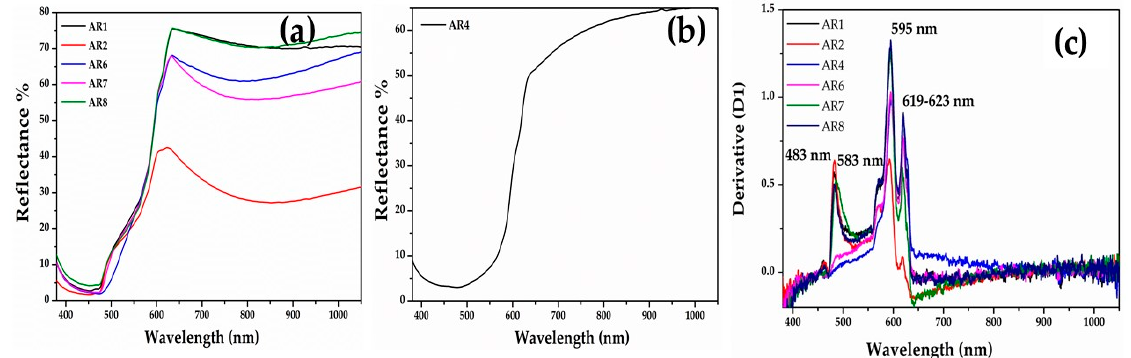
Figure 9. FORS spectra of orange samples. ( a ) Yellowish orange samples; ( b ) reddish orange sample (AR4); and ( c ) first derivative of the orange samples .